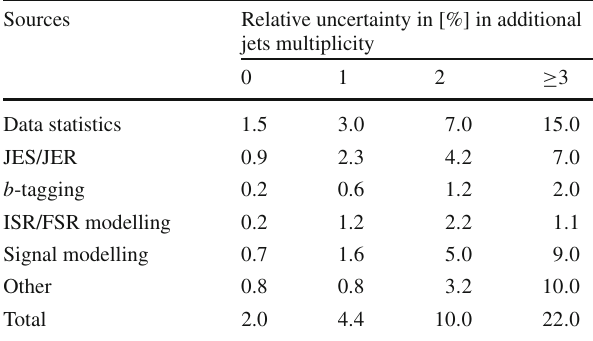
Table4 Summaryofrelativeuncertaintiesin[%]forthejetmultiplicity measurement using a jet p T threshold of 60 GeV. “Signal modelling” sources of systematic uncertainty includes the hadronisation, parton